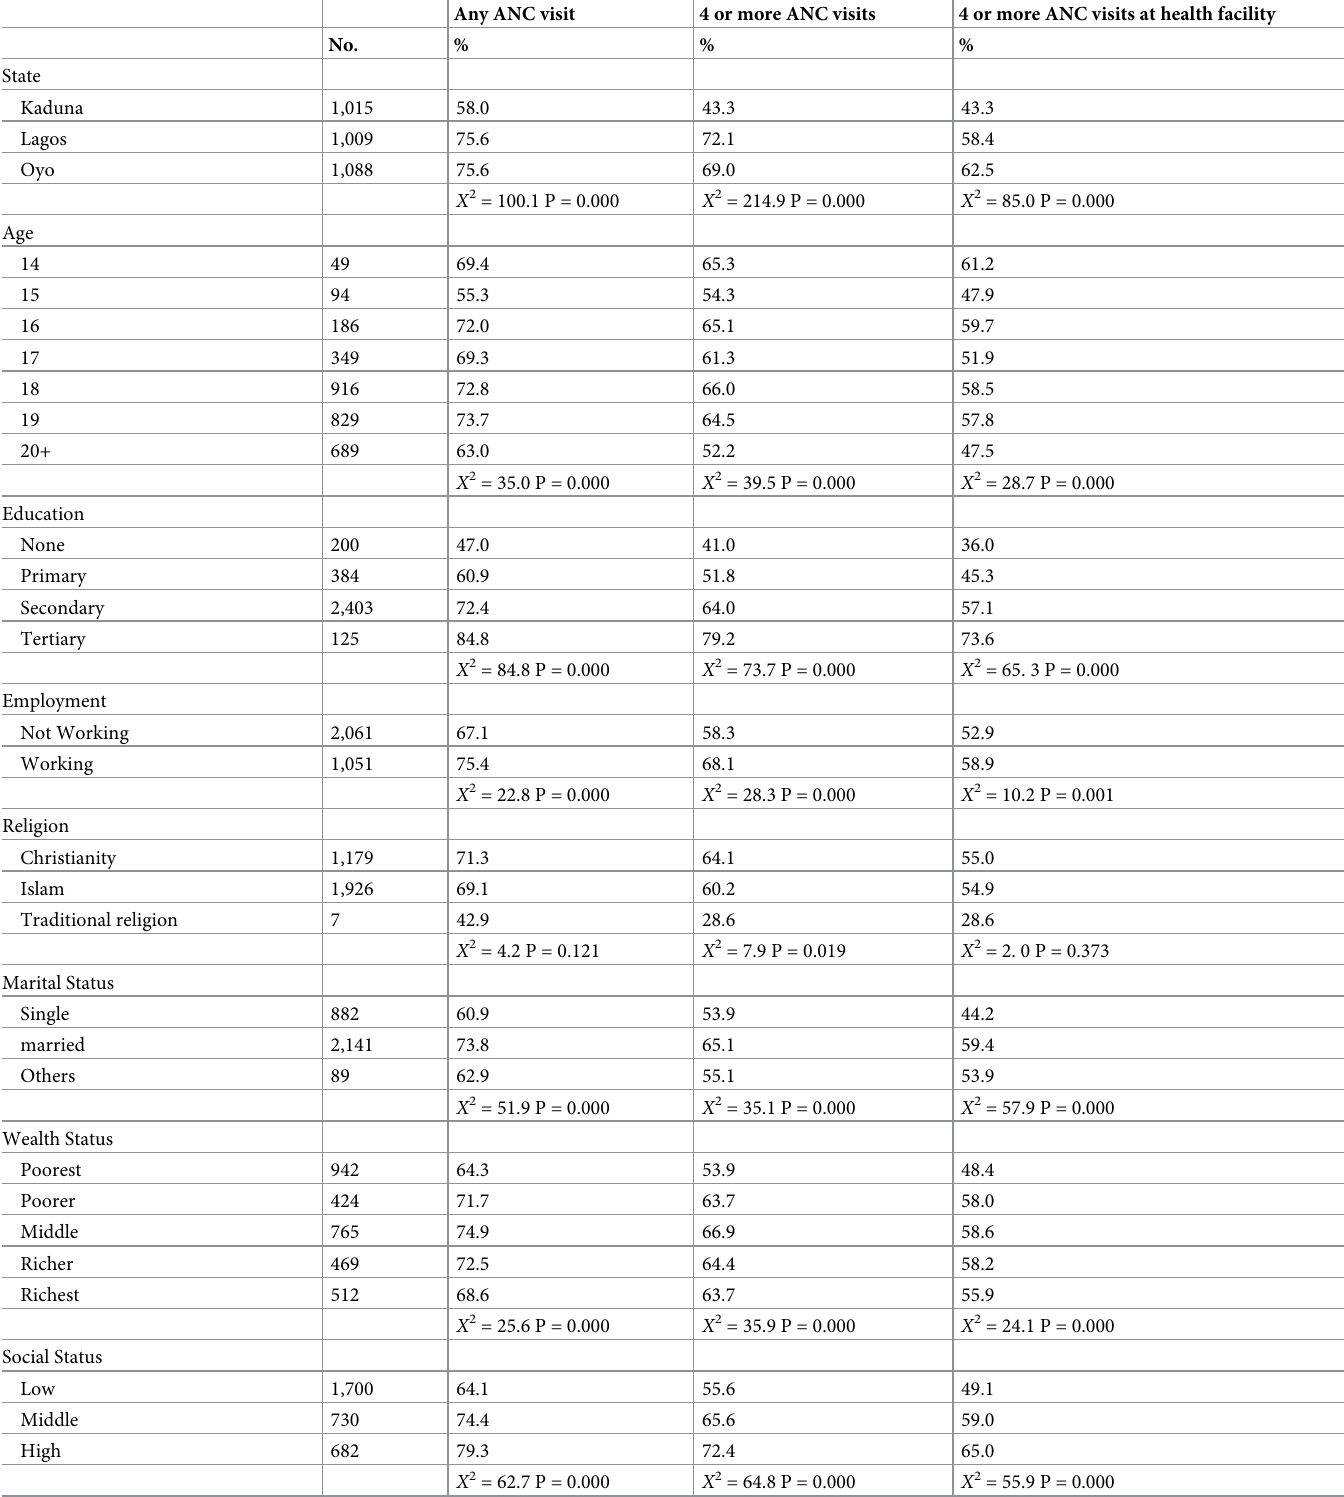
Table 3. Bivariate analysis between individual variables and outcome variables. Any ANC visit 4 or more ANC